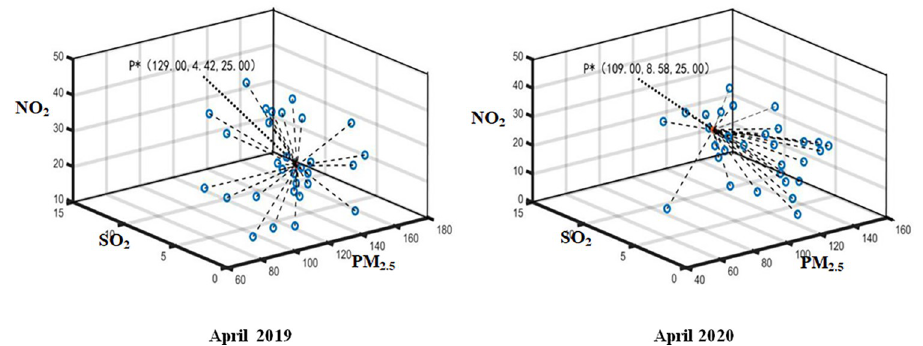
Fig 7. Aggregation result in April 2019 and 2020.